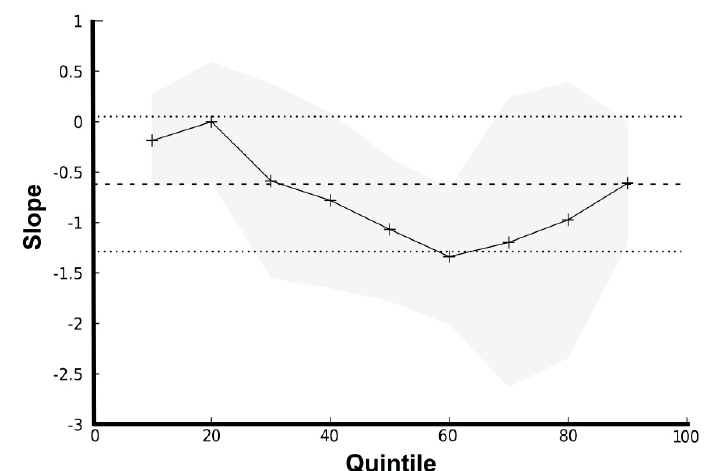
Figure 2. Graph of slopes for quintiles of semen volume versus logTSH. Note that the 50th quantile corresponds to the median quantile of the response (i.e., semen volume). The straight line with dashed line borders indicate the OLS ‐ R estimates with 95% confidence intervals, whereas the splined line with grey borders indicates the Q ‐ R estimates with 95% confidence intervals.